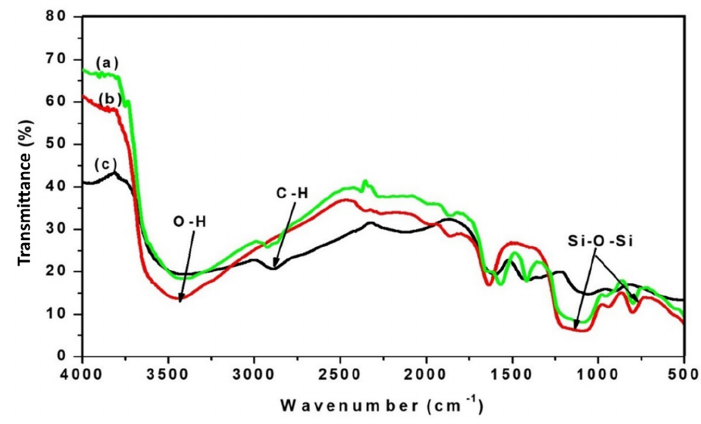
Figure 5. FTIR spectra of the chitosan–silica IOCM ( a ), silica particles ( b ), and neat chitosan ( c ).